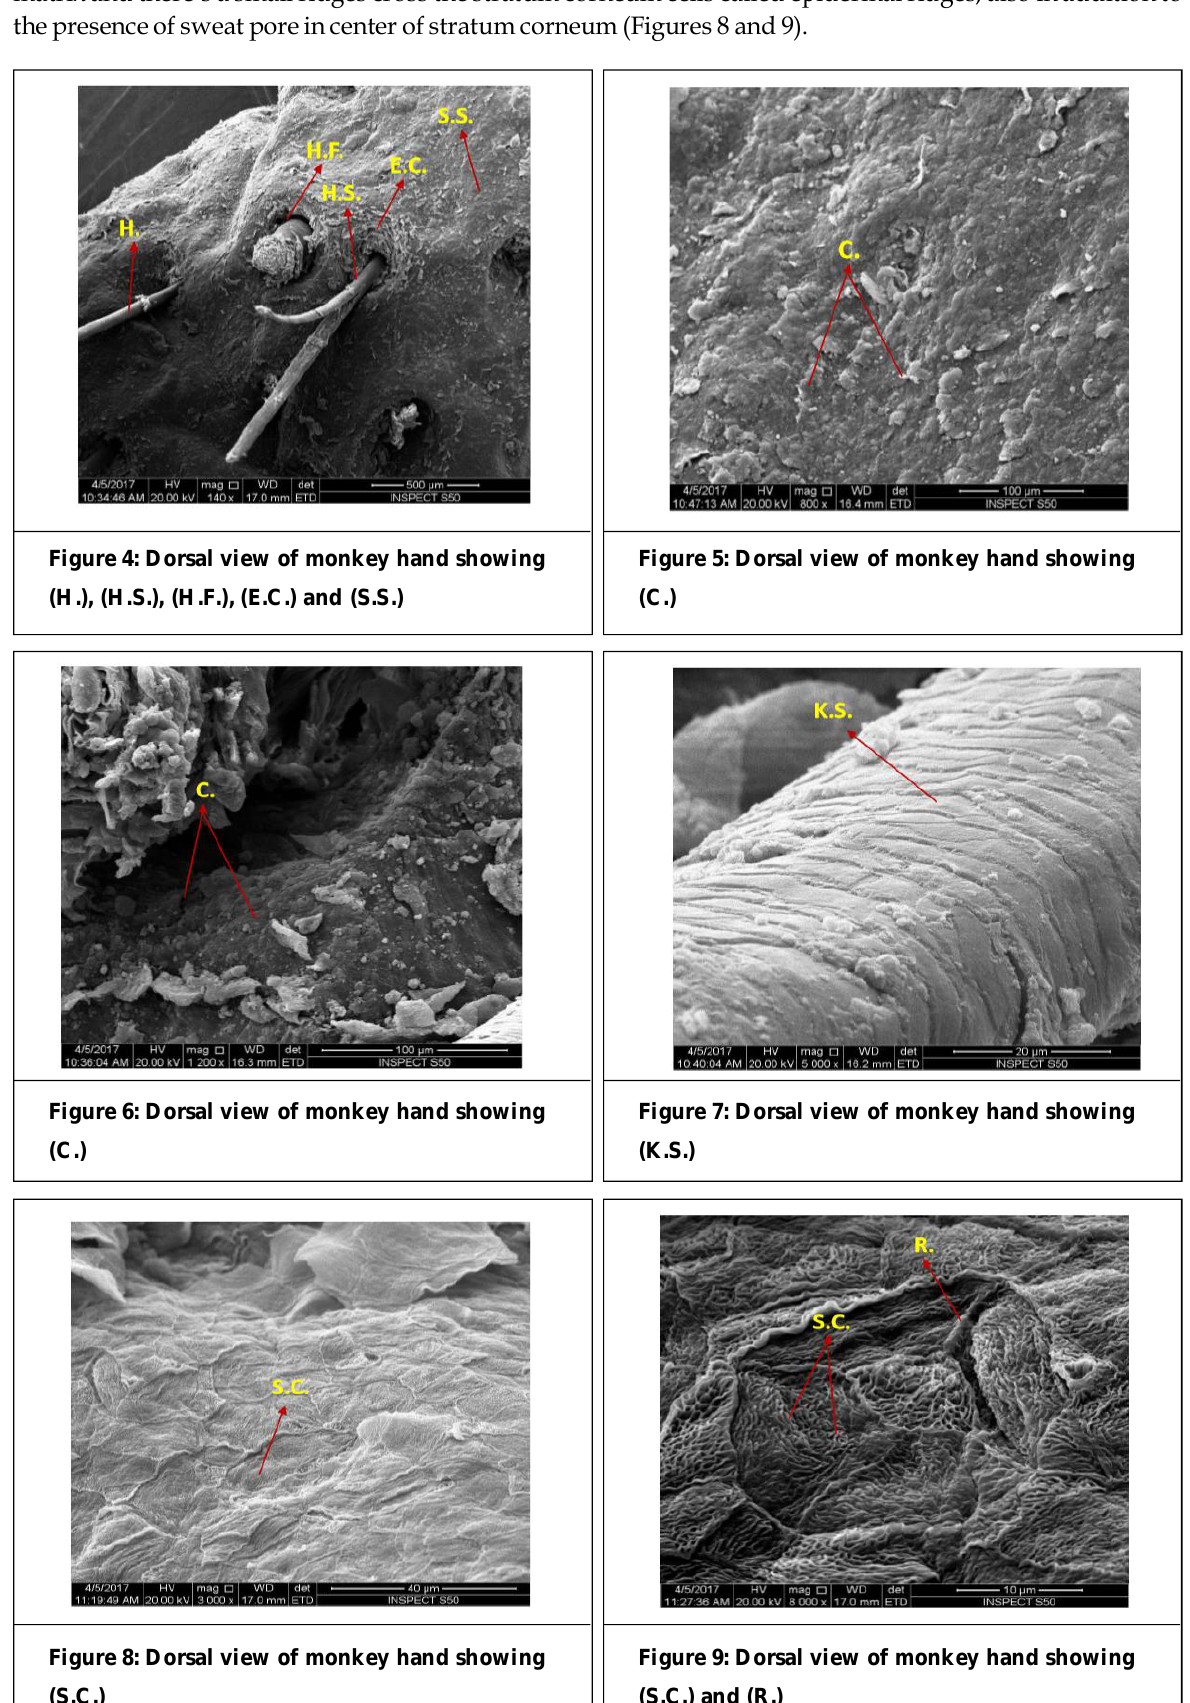
Figure 8: Dorsal view of monkey hand showing (S.C.)